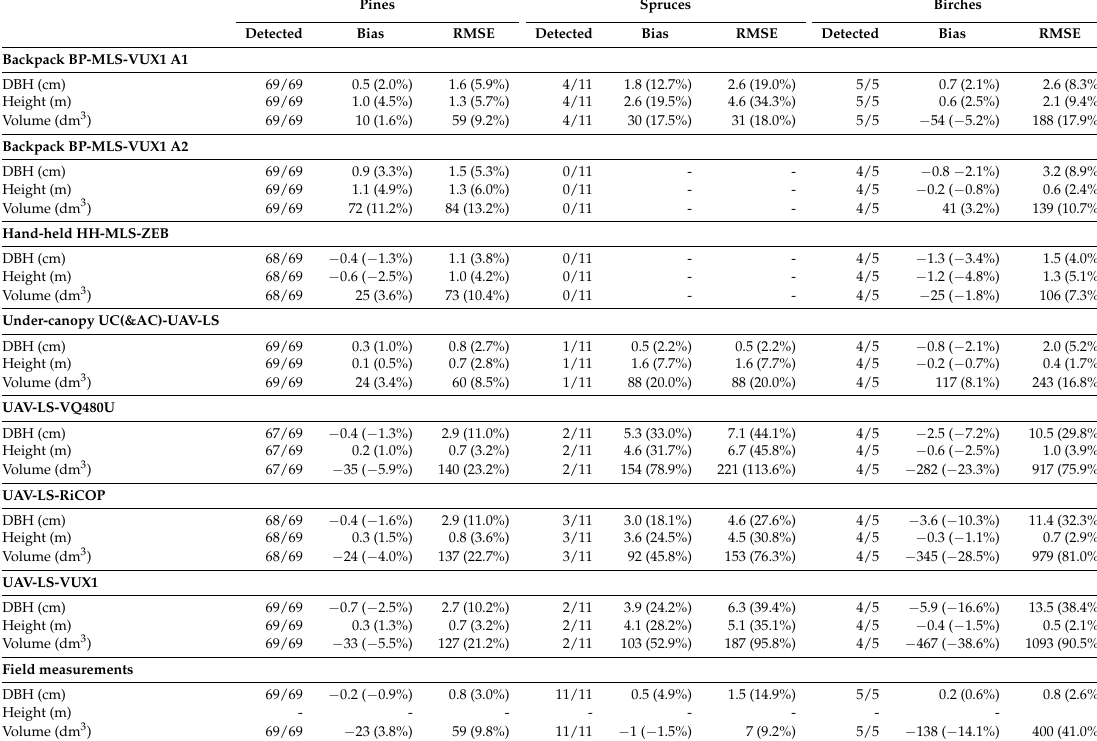
Table 8. Species-specific bias and RMSE of DBH, tree height, and stem volume for the detected trees based on the different mobile and airborne laser scanning methods. In the case of the under-canopy UAV LS, we have extracted the tree heights used for the stem volume computation from an above-canopy (AC) UAV measurement. In the table, we also compare field-measured DBHs and stem volumes against our reference measurements. The stem volumes of the field measurements were estimated by using the national Finnish allometric model [57] whose inputs are the field-measured DBH, tree height, and tree species. It was not possible to estimate the bias and RMSE for field measured heights since they were used as the reference heights for all the measurements. Note that the units for the bias and RMSE are provided inside parentheses after each tree attribute in the leftmost column.